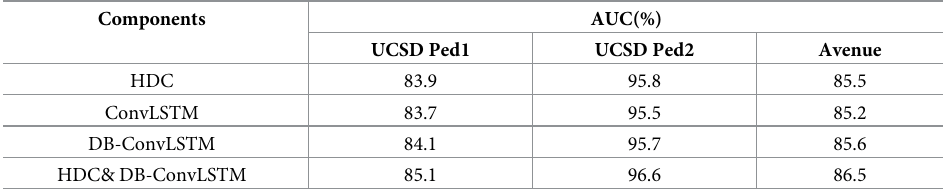
Table 3. Effect of different parts for prediction module on different datasets.